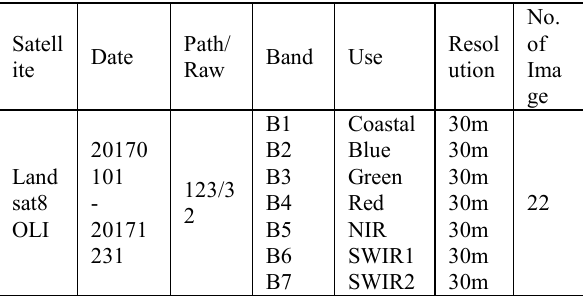
Table 1. Dense stacking of imagery throughout the year